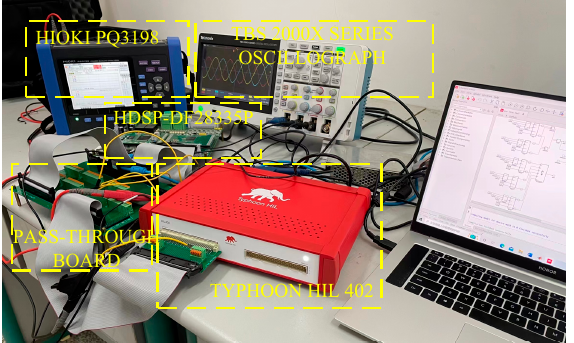
Figure 14. Semi-physical experimental platform.